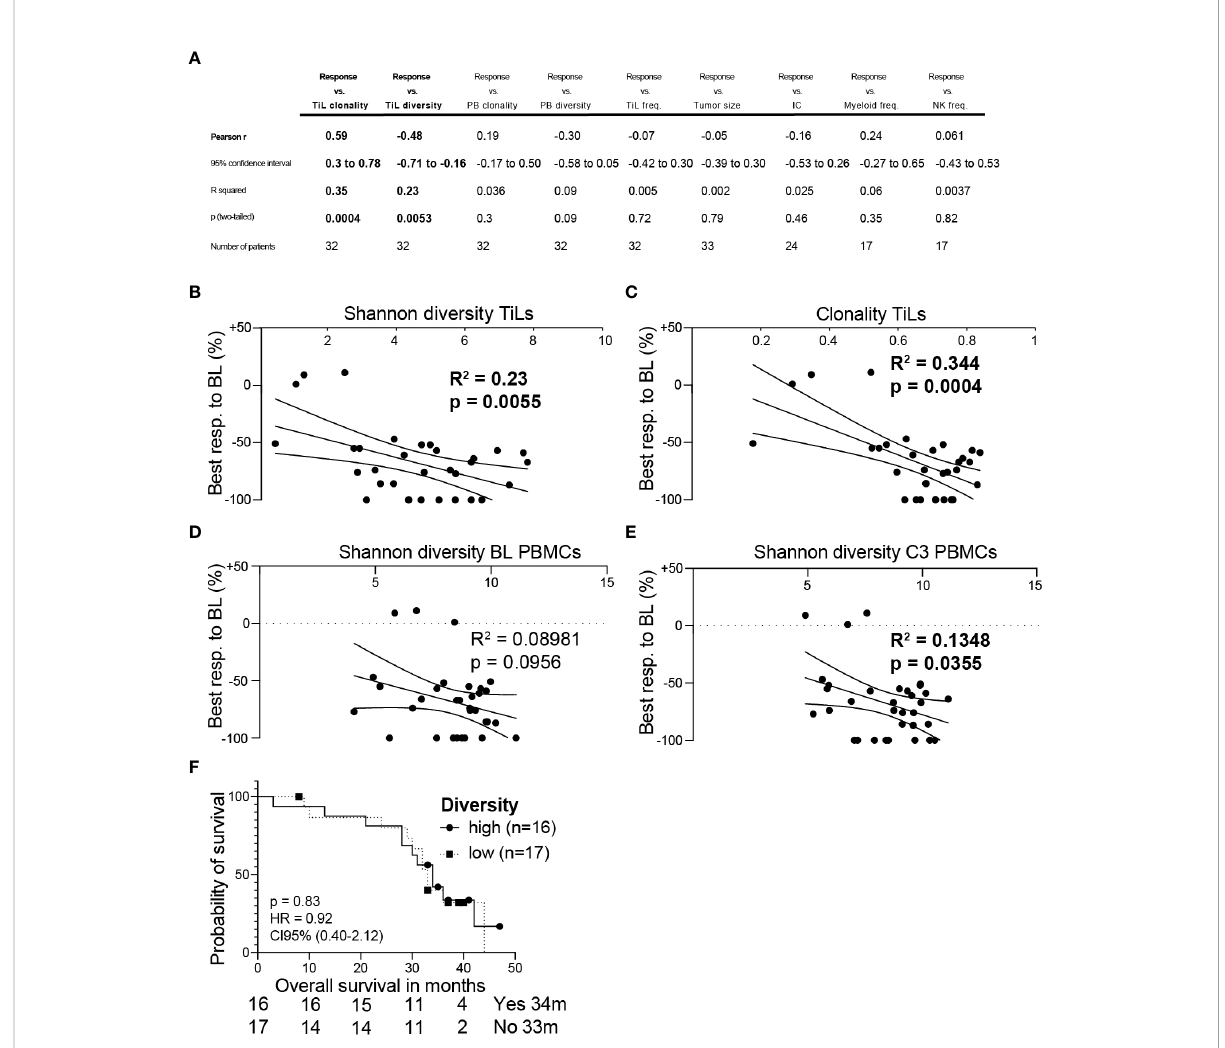
FIGURE 3 (A) Multi linear correlation analysis of indicated markers with the best radiological response. Shannon diversity of TiLs (B) or clonality of TiLs (C) was correlated with radiological response. Shannon diversity of baseline (BL) PBMCs (D) or PBMCs after three cycles of chemotherapy (E) was correlated with radiological response. (F) The analyzed cohort was separated into patients having a higher than median TiL diversity vs. lower TiL diversity. Overall survival is shown in the Kaplan-Meier estimator. Multi linear correlation and Pearsons´s r (A) , simple linear regression (B – E) or log-rank Mantel-cox test (F) was calculated. P values are